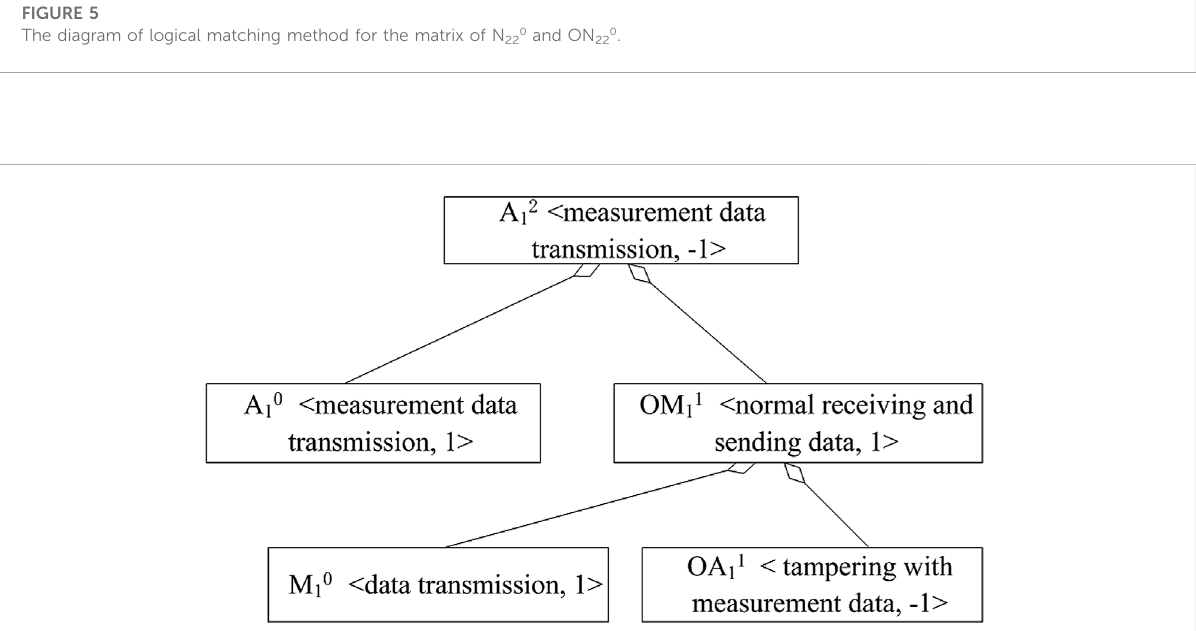
FIGURE 6 The diagram of logical matching method for the matrix of N 33 0 and ON 33 1